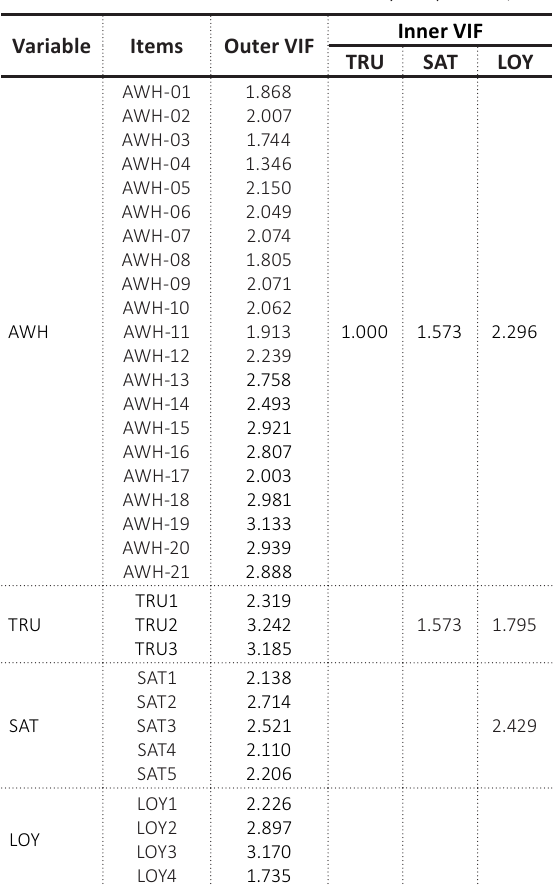
Table 4. Variance inflation factor Table 5. R 2 and R 2 Adjusted